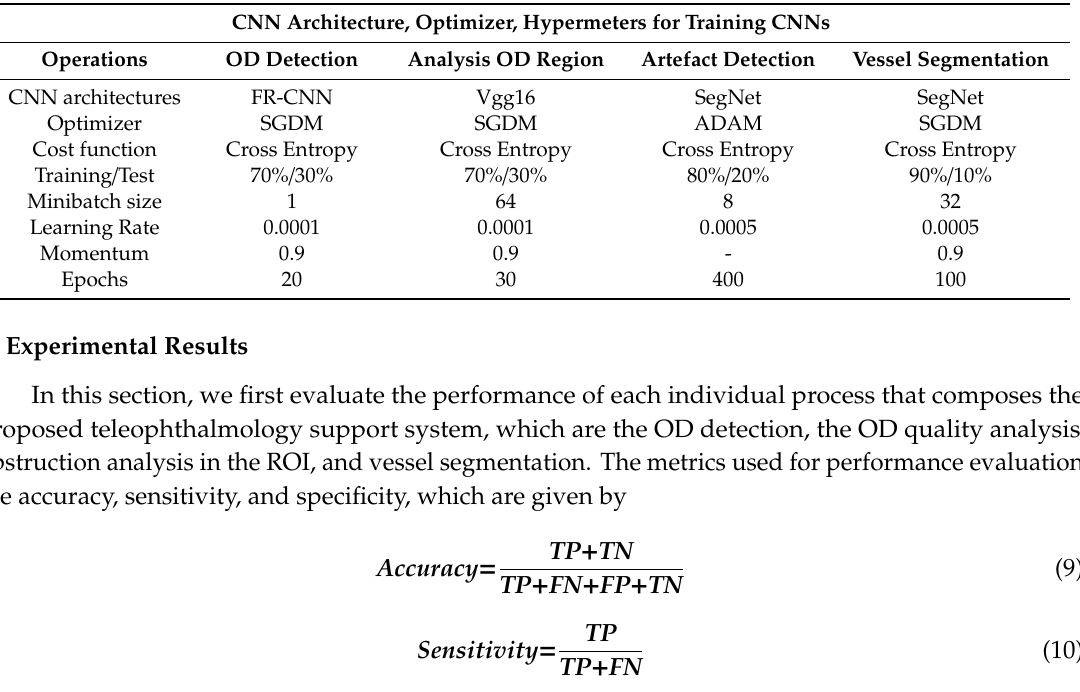
Table 2 resumes the architecture, optimizer and hyper-parameters used in each process of the proposed system. The values of the hyper-parameters are determined by trial and error. Table 2. CNN architecture and hyper-parameters used in each operation of the proposed